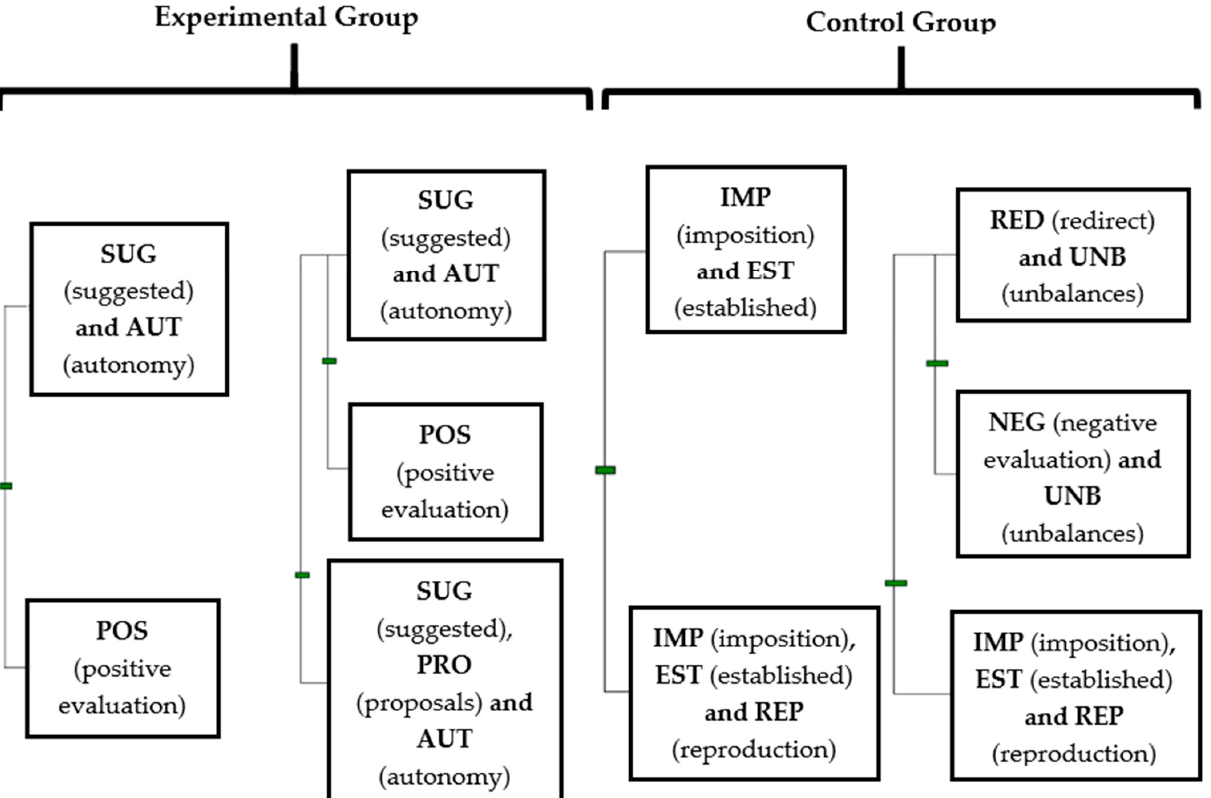
Figure 1. Representative dendrogram of teachers’ performance, experimental (EG) and control (CG), and students’ response in the analysed sessions of the intervention.